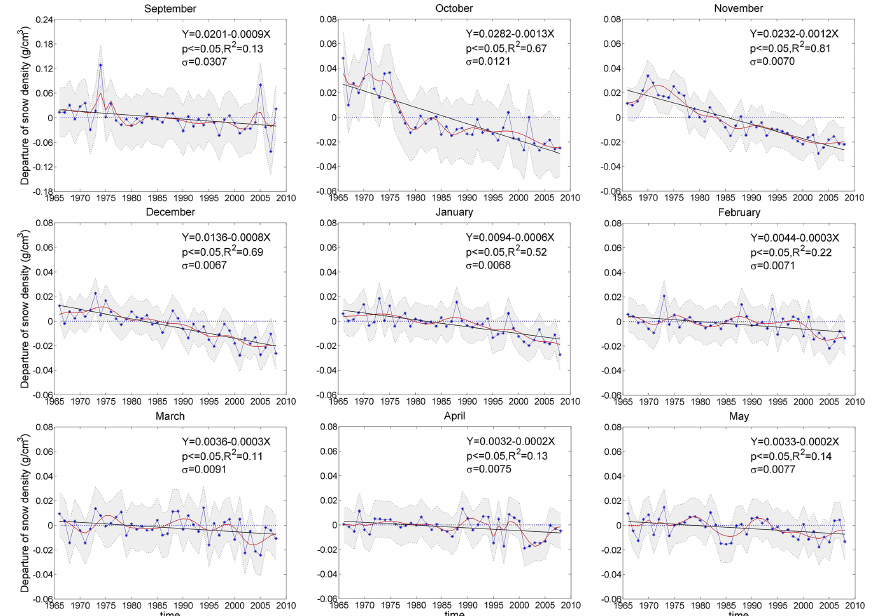
Fig. 8. The annual variation of monthly snow density across the former USSR from 1966 through 2008, with respect to the 1971–2000 mean. The thin solid line with asterisk is the computed annual mean of snow density; the solid curve represents the trend of wavelet analysis; the gray area represents one standard deviation from the 1971–2000 mean for each year; the thick solid line of change trends in snow density with time. y represents snow density in gcm − 3 and x represents time in snow cover years, 1966 was the first snow cover year, therefore, x ranged from year 1 (1966) to year 43 (2008) in the simulation of annual mean snow density. p is the confidence level for the coefficient estimates, R 2 is the goodness of fit coefficient, and σ is one standard deviation. The y axis scale is larger in September, which is three times as large as the scales in other